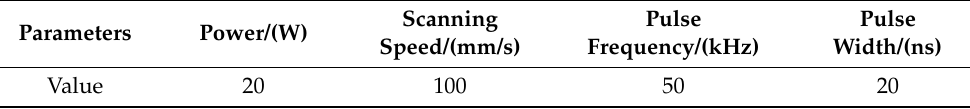
Figure 1. Laser ablation setup and textures mode ( a ) laser ablation system; ( b ) the designed ablation textures. Table 2. Nanosecond laser ablation parameters.